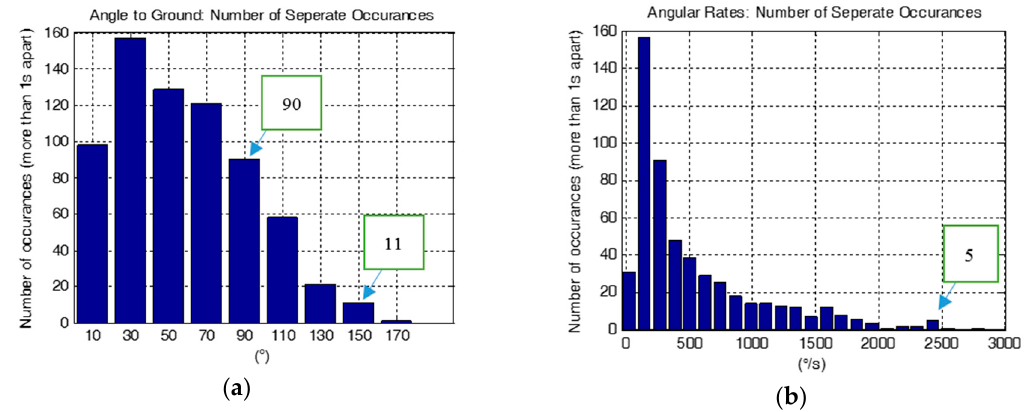
Figure 5. ( a ) Modified histogram of the angle between the device x -axis and nadir of the same data recording from Figure 4. The number of occurrences is counted, i.e., when the arm is raised to a certain angle, and only one occurrence is counted even though multiple data points recorded the event. Events must be more than one second apart to count as separate occurrences; ( b ) Histogram of angular rate magnitude. The number of occurrences is counted, i.e., when the arm rotates at a certain rate, and only one occurrence is counted even though multiple data points recorded the event. Events must be more than one second apart to count as separate occurrences.